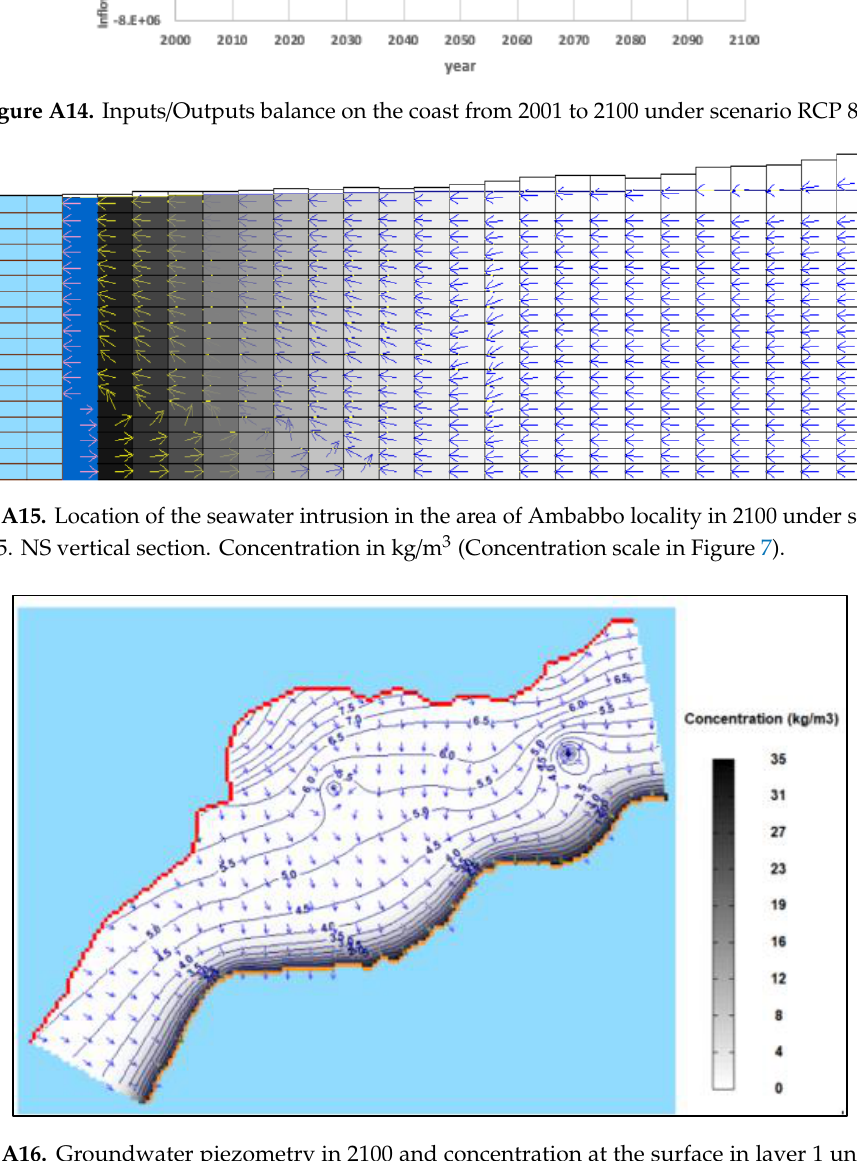
Figure A16. Groundwater piezometry in 2100 and concentration at the surface in layer 1 under the RCP 8.5 scenario.